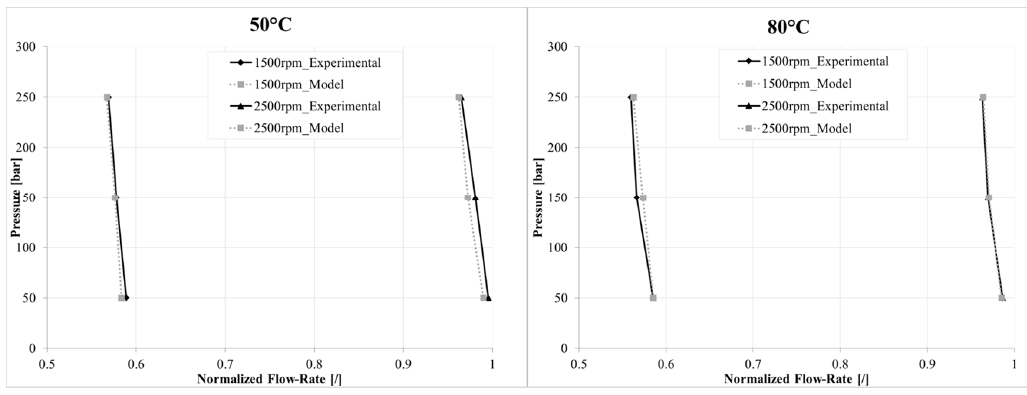
Figure 13. Pressure vs. delivery flow-rate comparison at 50 and 80 °C.